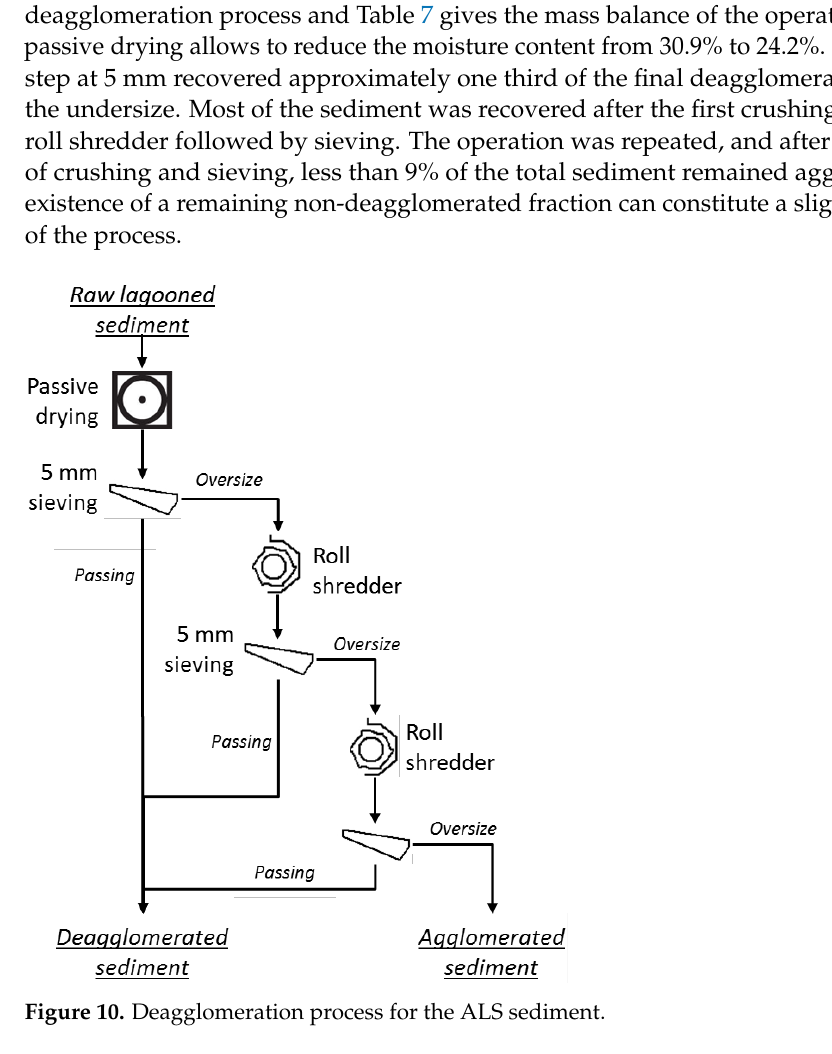
Table 7. Mass balance of the ALS sediment deagglomeration process.